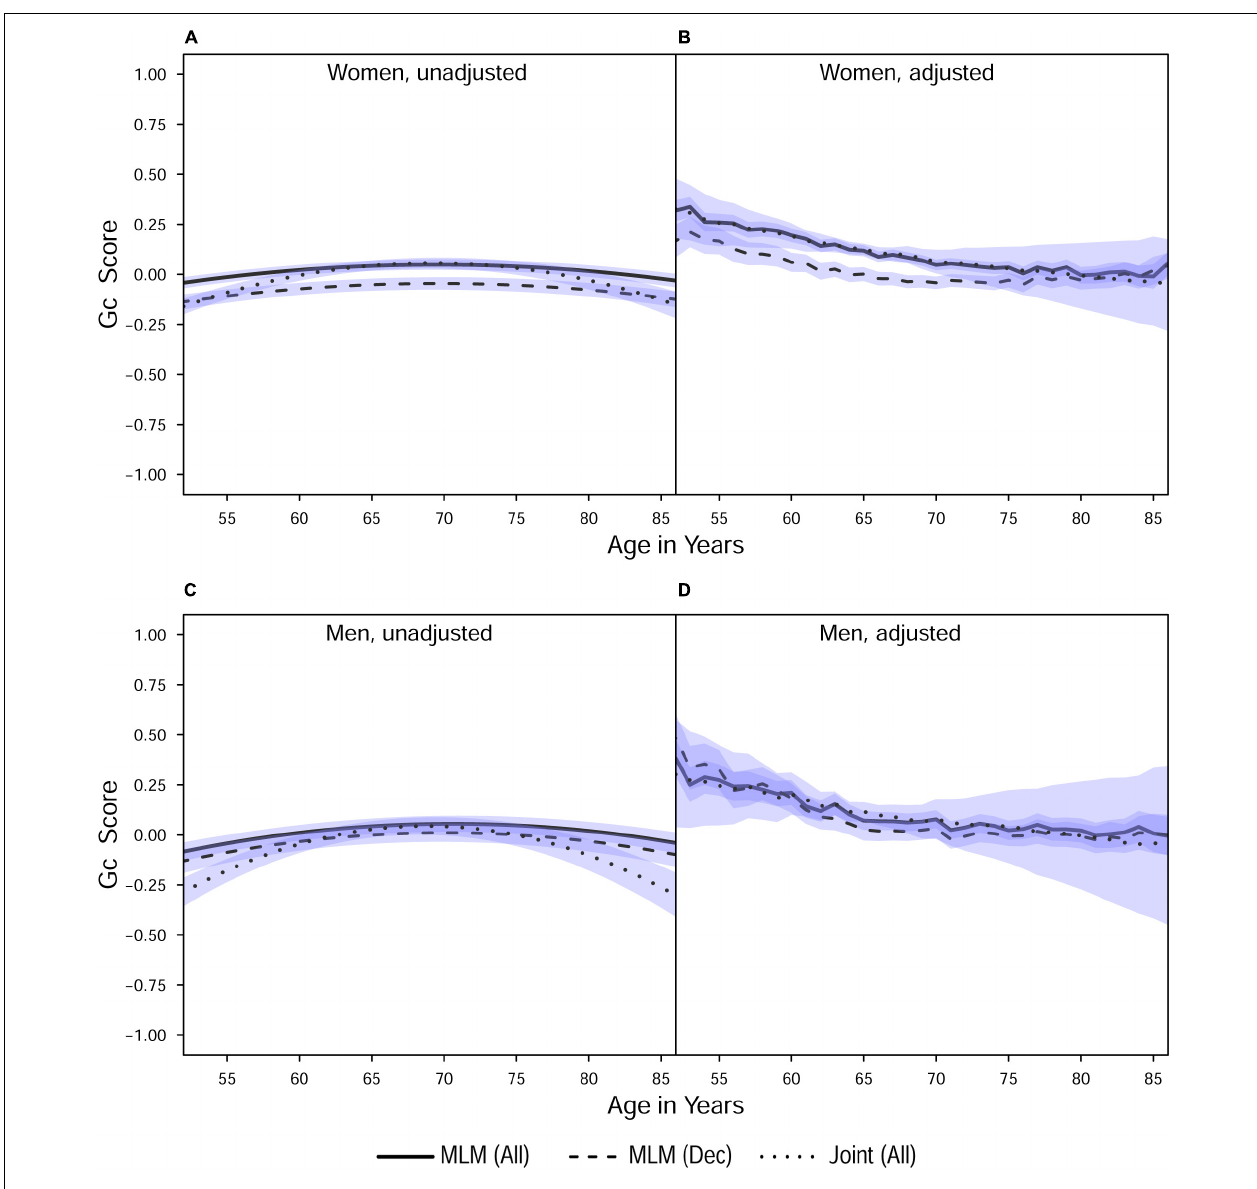
FIGURE 1 | Estimated average changes in crystallized intelligence (Z-scaled) by chronological age. (A,C) Trajectories unadjusted for starting age and health-related covariates. (B,D) Trajectories adjusted for differences in starting age, SRH, and tobacco smoking. MLM, standalone, multilevel model trajectories; Joint, joint longitudinal-survival model trajectories; All, data from decedents and survivors; Dec, data only from decedents. Shaded regions indicate 95% credible intervals for the group average